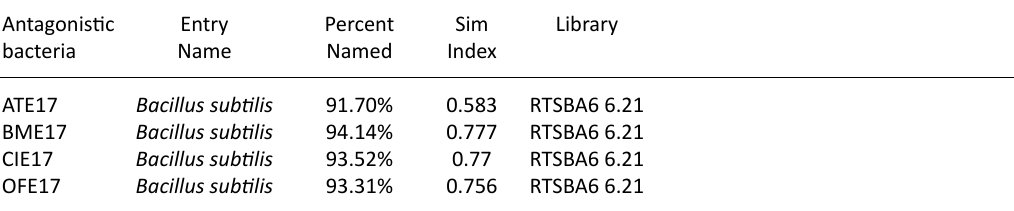
table 2. Endophytic bacteria identification by microbial identification system based on Fatty Acid Analysis (MIDI) Antagonistic